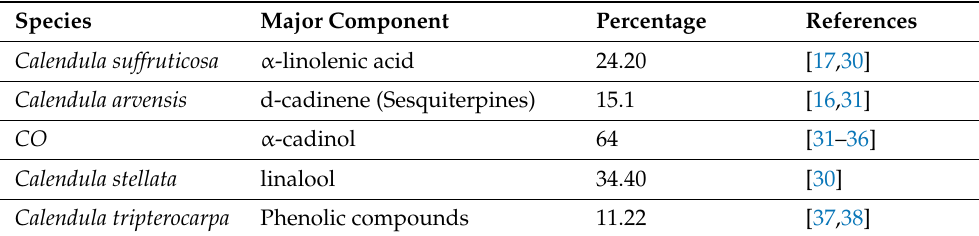
Table 1. The major constituents and percentages of various Calendula species [29].